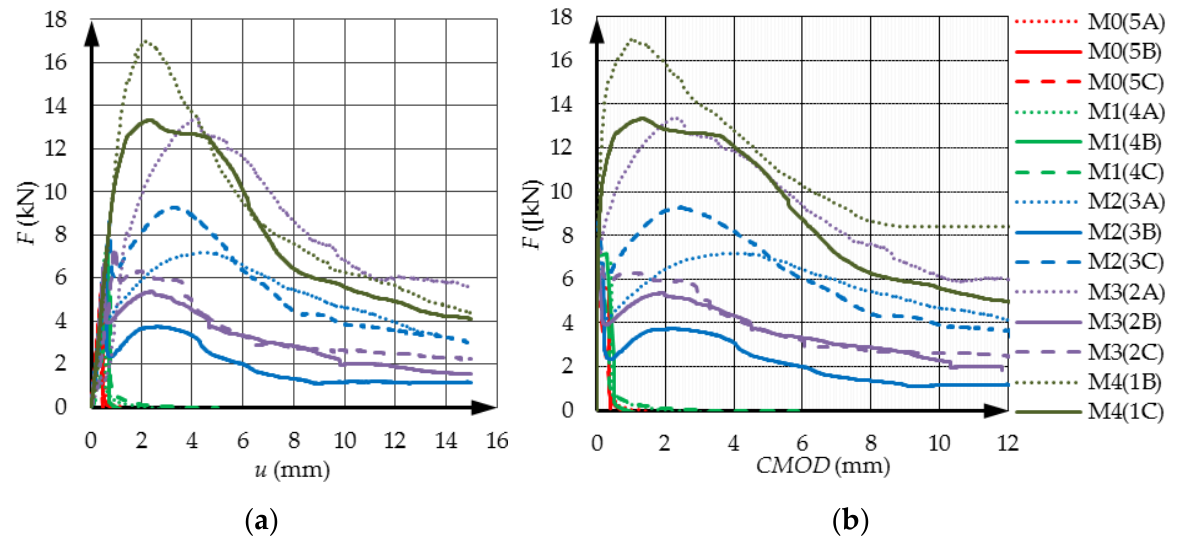
Figure 6. Equilibrium paths in the case of the tested materials and subsequent repetitions—force as a function of: ( a ) displacement; ( b ) crack mouth opening displacement ( CMOD ).